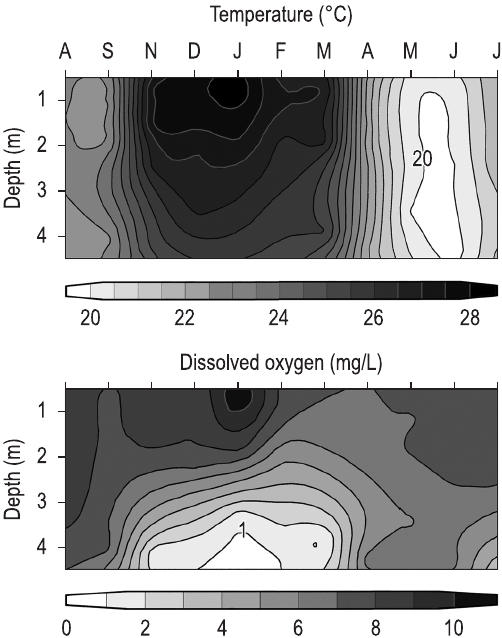
Figure 3. Isopleths of temperature and dissolved oxygen from August 1998 to July 1999.